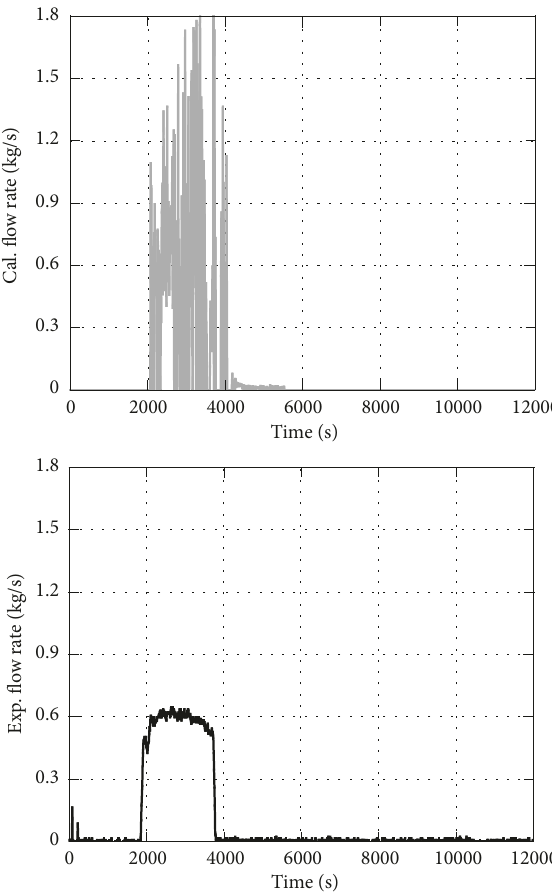
Figure 16: TR-LF-17 test and RELAP5 results for ACC flow rate in loop A.